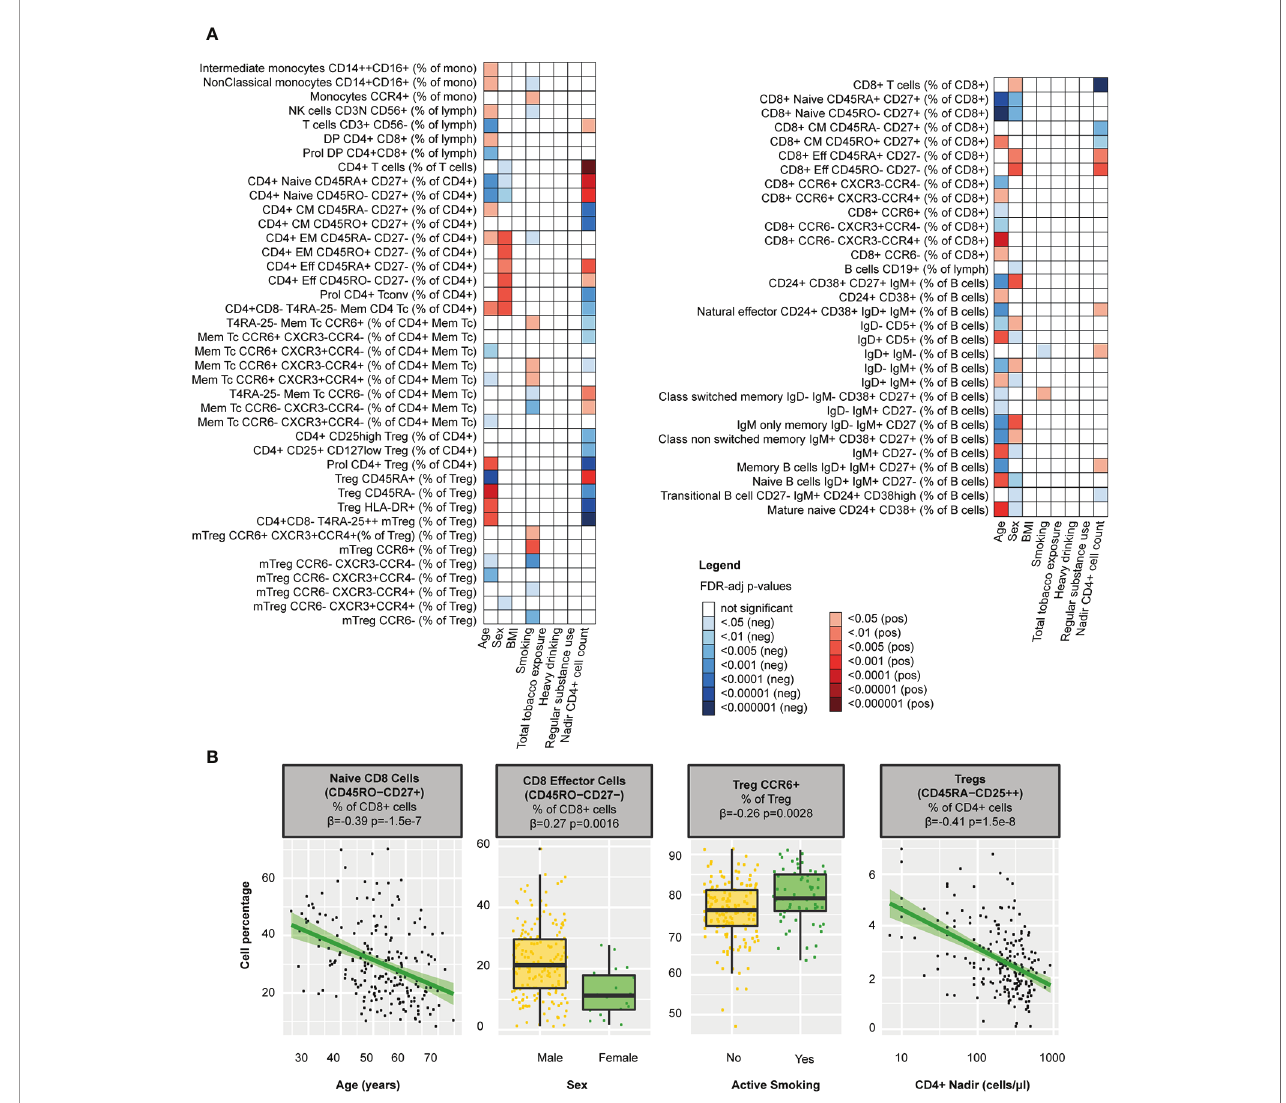
FIGURE 3 | Clinical determinants of WBC percentages in PLHIV (A) Heatmap of WBC percentages (n=108 WBC subsets) that were signi fi cantly associated with any of the clinical determinants tested in 211 PLHIV; WBC subsets that showed no signi fi cant correlations with any of the parameters (n=37) have been removed from the fi gure. (B) Examples of WBC subsets that were signi fi cantly associated with age, sex, smoking, or CD4 nadir. Inverse-rank transformed data were analyzed using linear regression and adjusted for age, sex, sampling time, and season. For color coding of the FDR-adjusted p-values see legend. PLHIV, people living with HIV; WBC, white blood